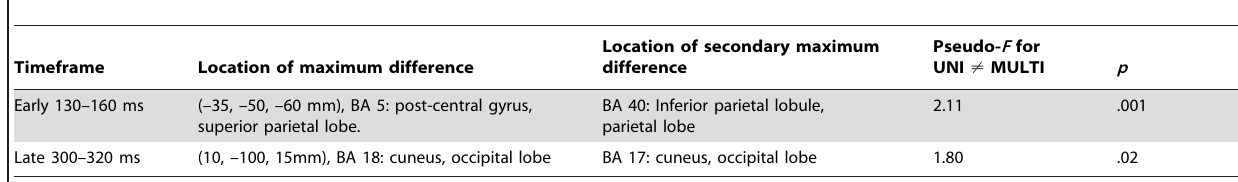
Table 1. Locations of the maximum difference (maximum pseudo- F statistic) in the early and late time intervals.